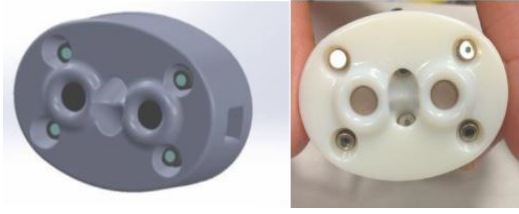
Figure 3: Design of the probe in SolidWorks and the prototype